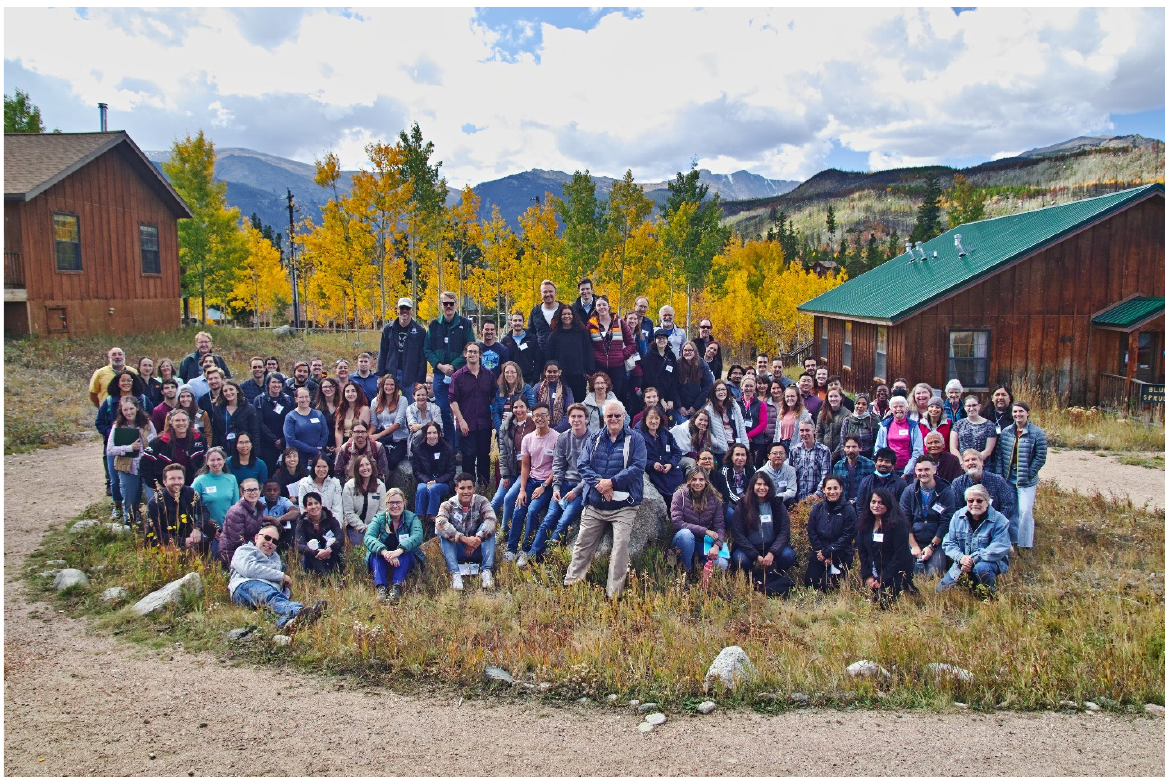
Figure 1. Attendees at the 21st Annual Rocky Mountain Virology Association Conference.